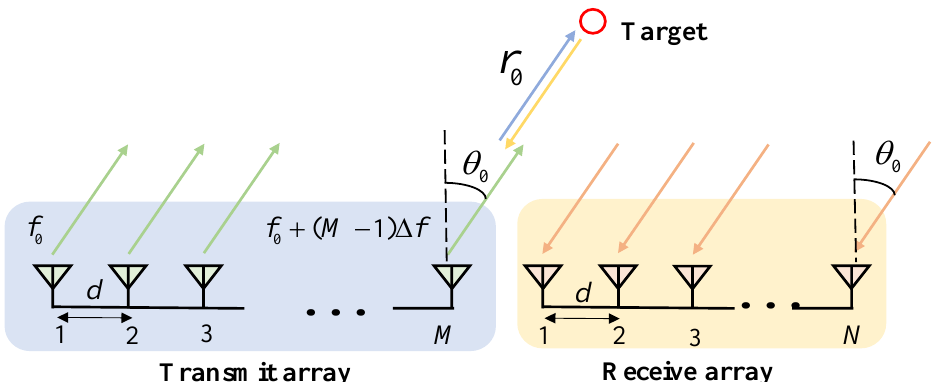
Figure 1. FDA-MIMO Radar